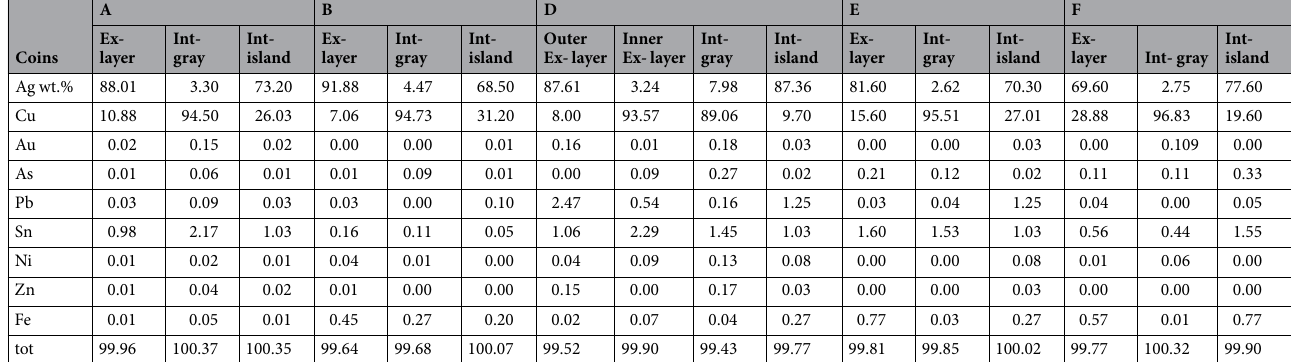
Table 2. Chemical analyses of representative coins of group 1, obtained using microprobe analysis on the external and deeper layers. Ex-layer: external layer; Int-gray: internal core (copper-rich β -phase); Int-island (silver-rich α -phase).